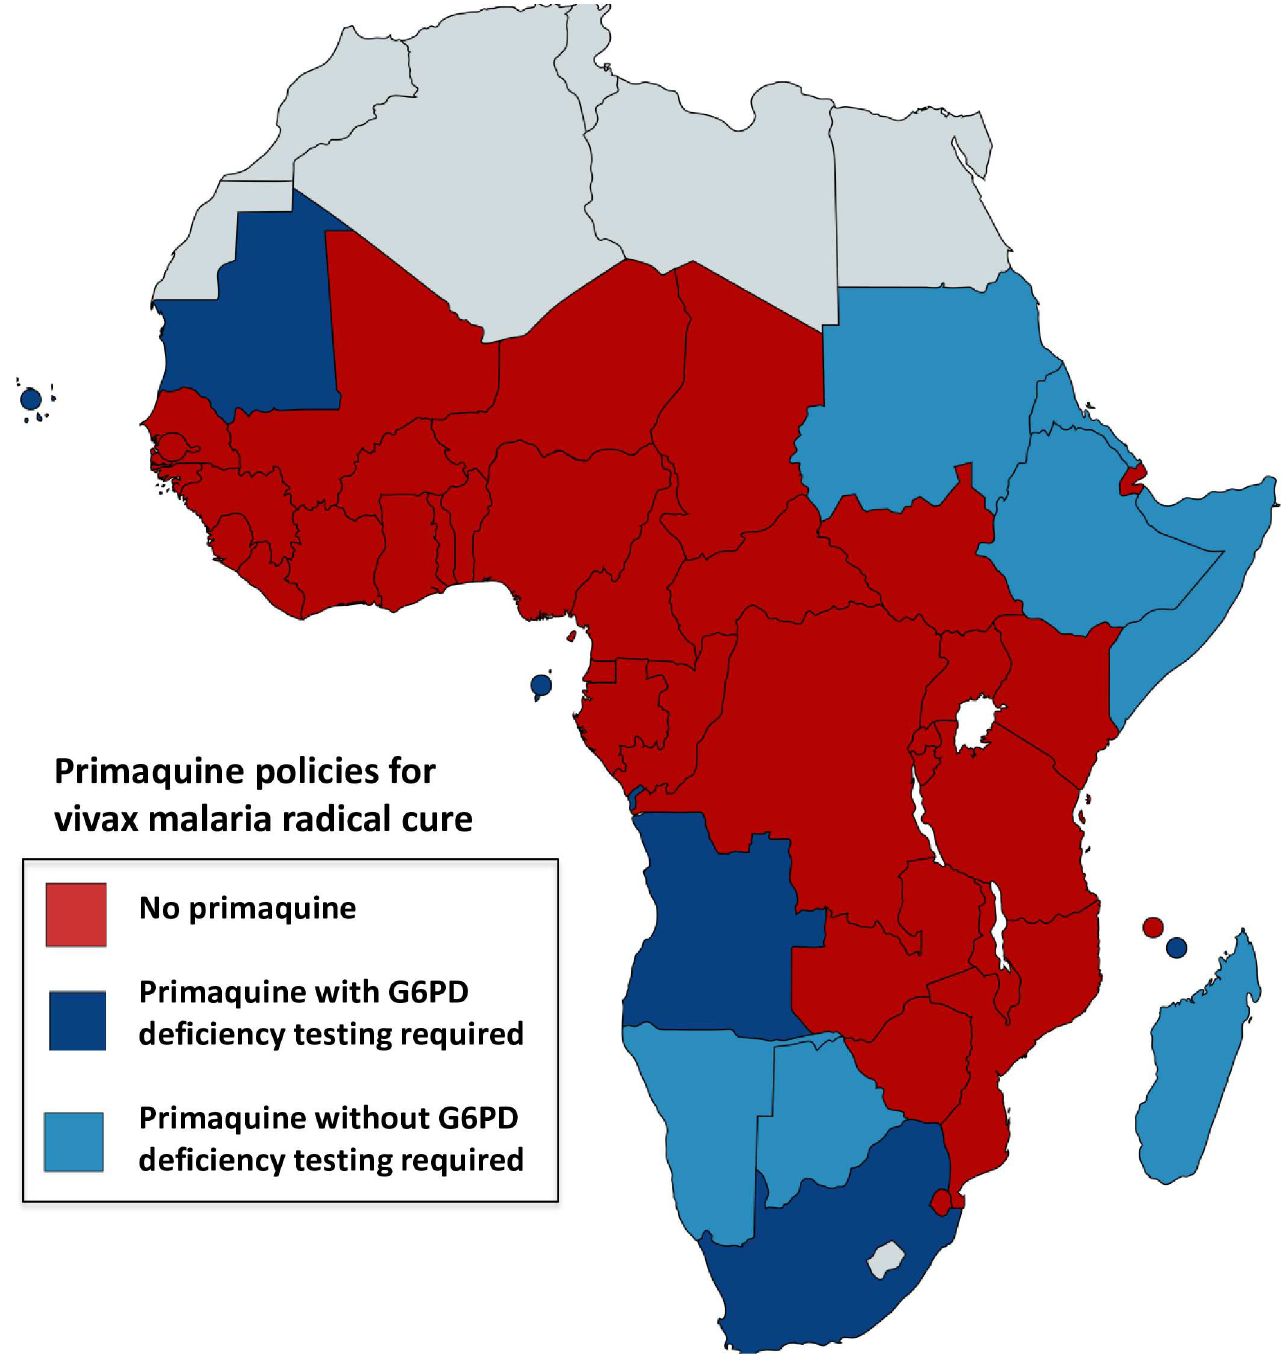
Fig 2. Radical cure primaquine policies in African countries. Most countries do not include primaquine in their malaria treatment policies or have no policy (shown in red). Countries that have radical cure for vivax malaria (0.25 mg/kg/day for 14 days) as policy are shown in blue; dark blue: G6PD deficiency testing required prior to primaquine treatment, light blue: testing not required. Table 4 provides specific details on countries’ policies and implementation and/or upcoming modifications.